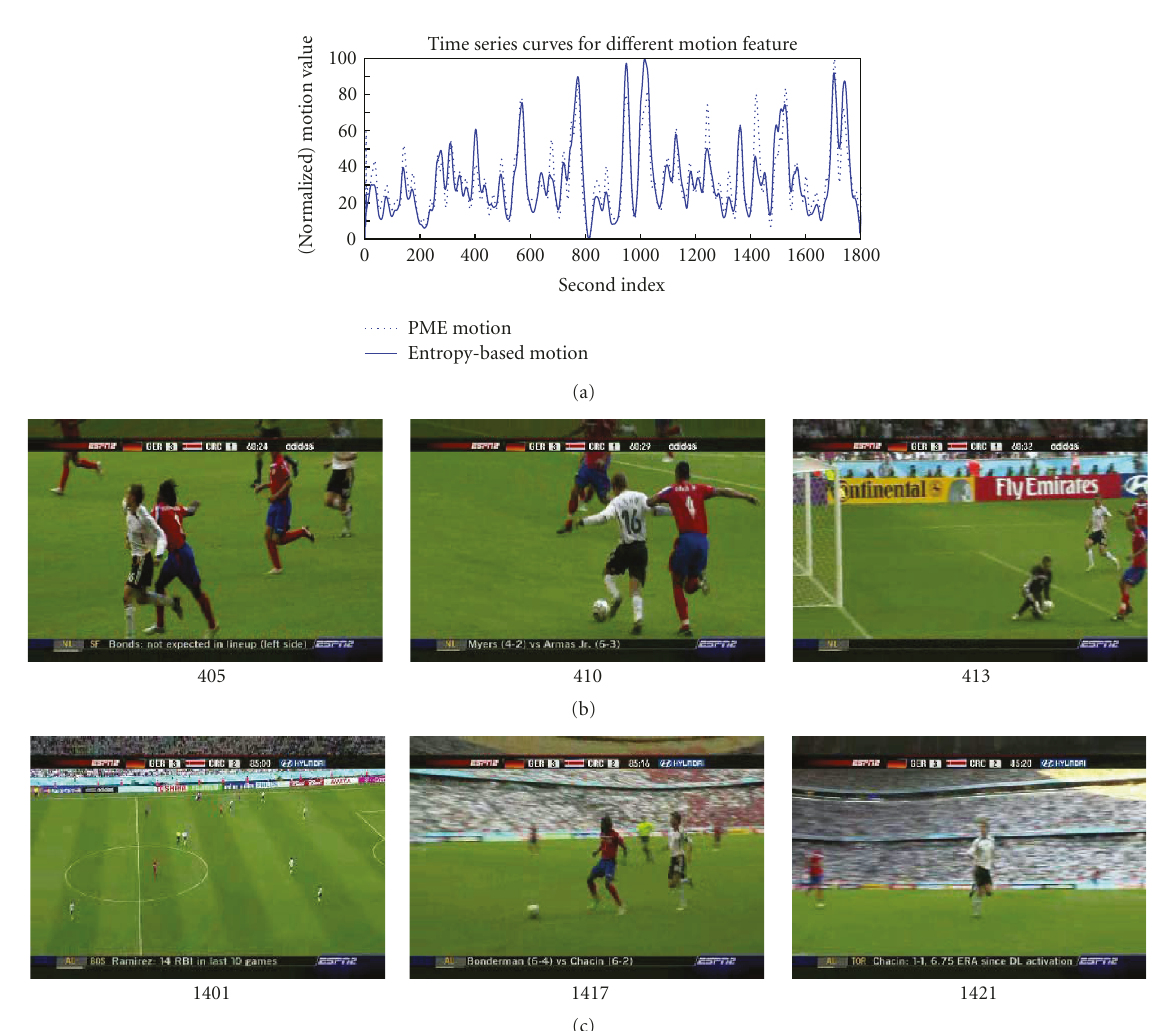
Figure 2: (a) An example of the EMV and PME [11] curves generated by the same sports video sequence, (b) attacking event only detected by EMV feature, (c) non-event (false) only detected by PME